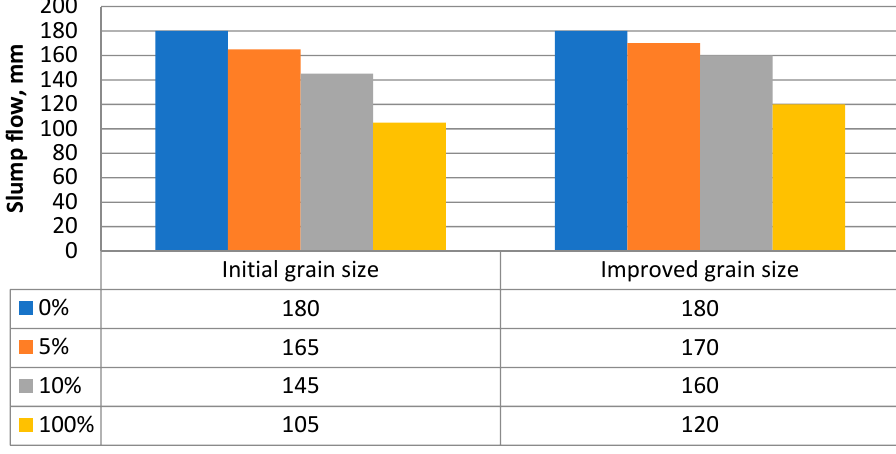
Table 3. Compressive strength and tensile strength in bending.